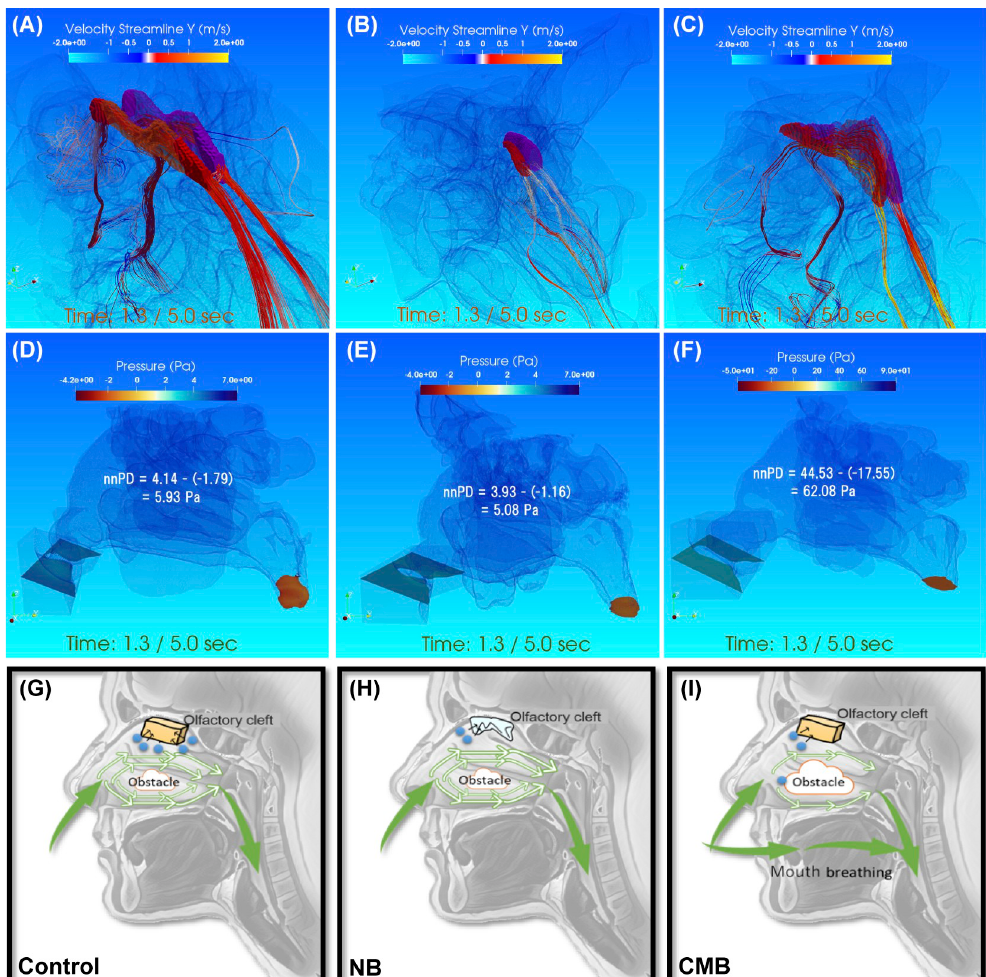
Fig 3. Characterization of a typical participant and conceptual diagram. a. - c. Characterization of a typical participant in the conductive olfactory disorder without nasal polyps (CODsNP). The olfactory cleft is colored in red (right side) and purple (left side). Streamline diagram under maximum pressure during inspiration from a right anterolateral view. a. Control: bilateral olfactory clefts have a normal shape. Air flows from the front of the olfactory cleft to the back during inspiration. b. Nasal breathing (NB): the latter half of the bilateral olfactory clefts does not exist. The flow velocity is slower than that of the control. c. The combined mouth breathing (CMB): bilateral olfactory clefts have a nearly normal structure, but the slit is thinner and slightly curved compared to the control. The flow velocity is faster than that of the control. d. - f. Pressure field at the plane containing nasal columella and the lower nasopharynx, and nasal-nasopharynx Pressure Drop (nnPD) during inspiration. d. Control: nnPD is 5.93 Pa. e. Nasal breathing (NB): nnPD is 5.08 Pa. f. Combined mouth breathing (CMB): nnPD is 62.08 Pa. There is one more digit on the scale in Figures d and e. g.-i. We created pattern diagrams based on the scanned data of the Control group, CODsNP_NB patients, and CODsNP_CMB patients. The “obstacle” represents the airflow difficulties through the lower turbinate, the middle turbinate, the upper turbinate, the nasal septum, and the nasopharynx. The blue dots represent an odorous substance. A slit without stenosis of the olfactory cleft is represented by an orange block and an olfactory cleft with structural abnormalities, such as stenosis and blind ends, is represented by a light blue polygon. The green arrows show the direction of airflow during